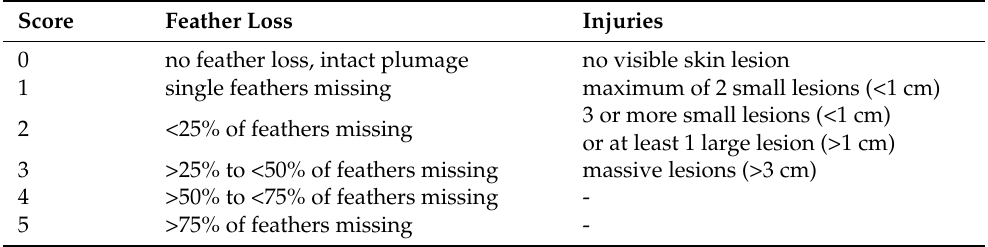
Table 1. Scoring system for the plumage evaluation and skin lesion evaluation used for the five body regions, the neck, back, tail, wing, and belly ([27], modified).